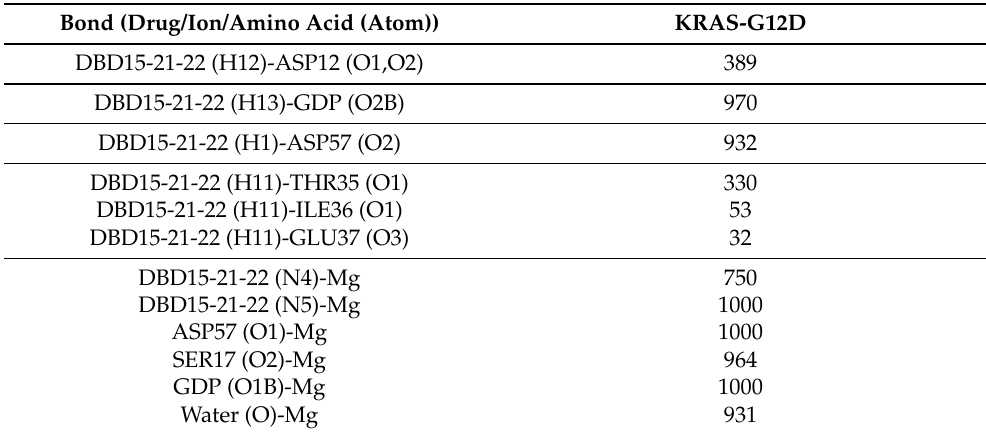
Table A3. Estimated lifetimes (in ns) of HB and CB interactions (Section 2 of main text, corresponding to Figures A11–A15). Total simulation time of 1 µ s. We indicate in “Bond” the atomic site of the designed new drug DBD-15-21-22 and the amino acid or ion involved in the HB or CB and the corresponding atoms in parentheses. Double labels indicate averaged